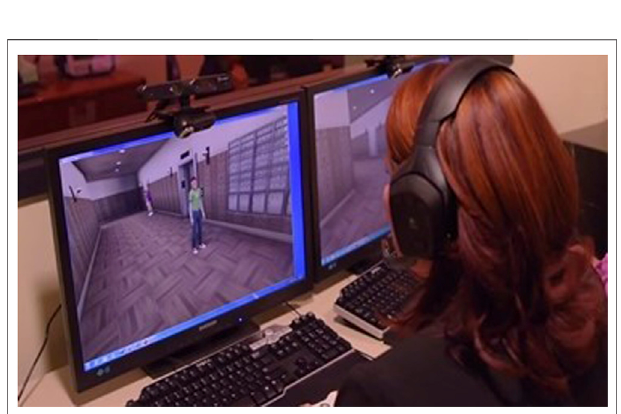
FIGURE 3 | Lead social coach. Virtual apartment, participant